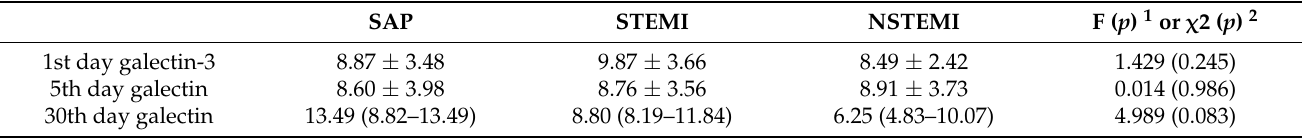
Table 3. Galectin-3 concentrations measured in venous blood on days 1, 5, and